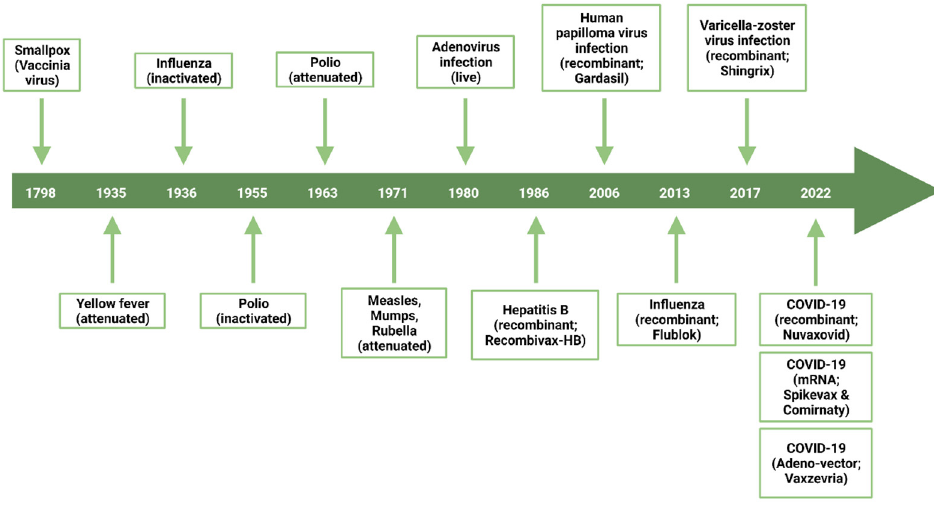
Figure 1. Timeline exposing major breakthroughs related to vaccine development for human uses. Historically, vaccines were composed of whole pathogens that were either attenuated or inactivated. Attenuated vaccines are usually produced by a series of cell passages under suboptimal conditions to select variants with lower virulence in humans, whereas inactivated vaccines are produced by physical and/or chemical treatments [7]. Although live-attenuated vaccines induce a robust immune response, the pathogen can still replicate and mutate within the host, which risks its reverting to the original virulent form [8]. In contrast, inactivated vaccines are safer but tend to induce a moderate immune response, particularly in children and the elderly [9]. To address these limitations, vaccine technolo- gies have shifted towards nucleic acid and protein-based vaccines (Figure 2) that aim to induce a targeted and safe immune response [10–13]. For instance, large-scale vaccination against SARS-CoV-2 has shown the efficacy and safety of nucleic acid-based vaccines.